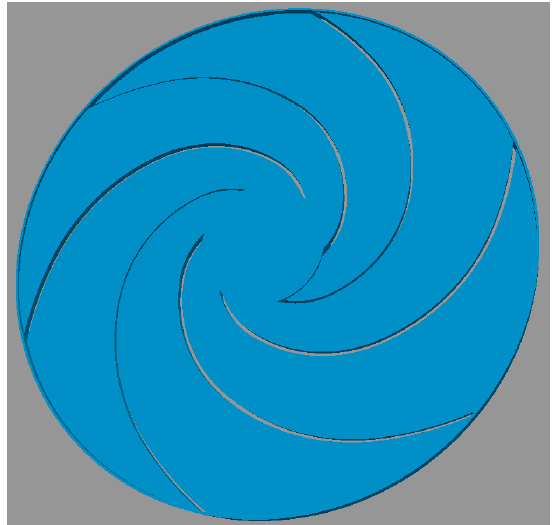
Figure 1: Back-side of the centrifugal pump impeller volume.